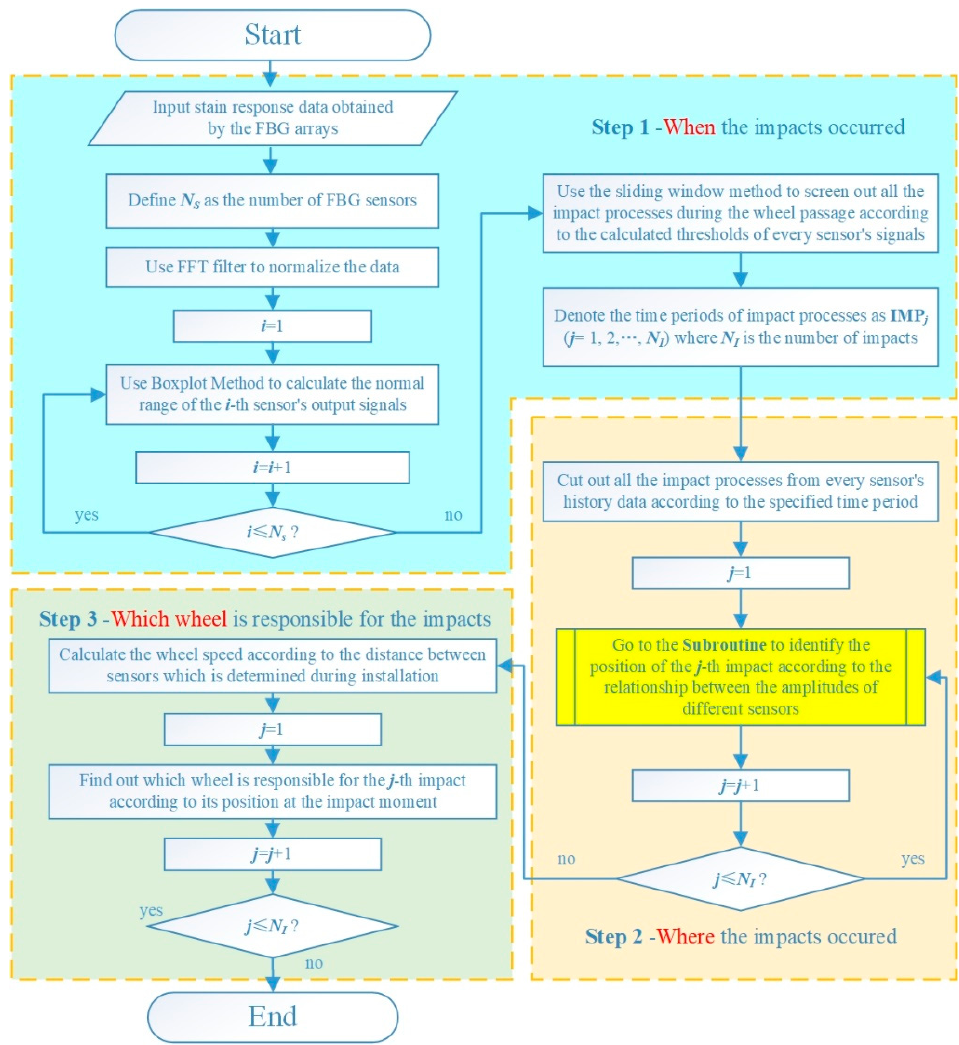
Figure 16. Main steps of the wheel flat recognition and positioning algorithm.